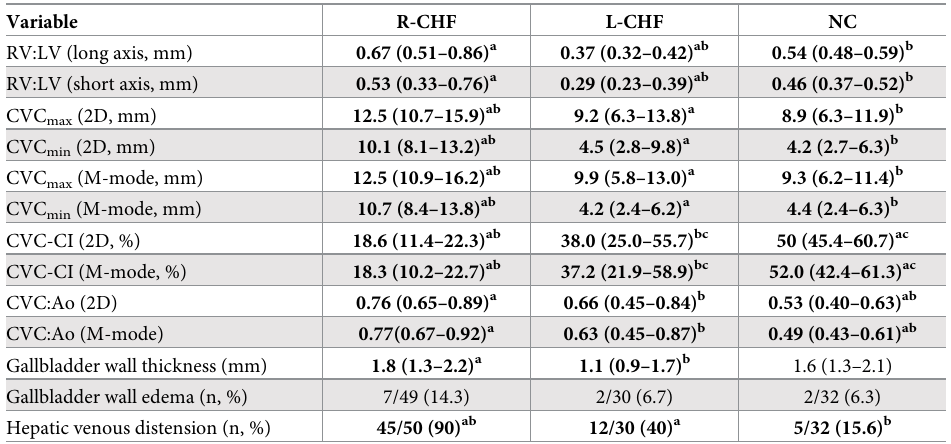
Table 2. Focused ultrasound indices by study group.